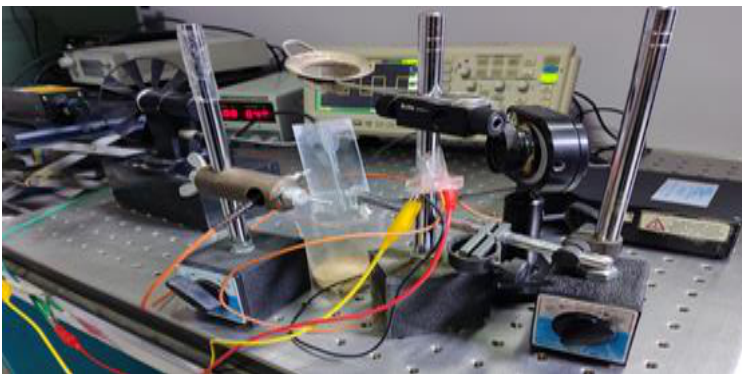
Figure 3: The system designed to detect dust pollutants.